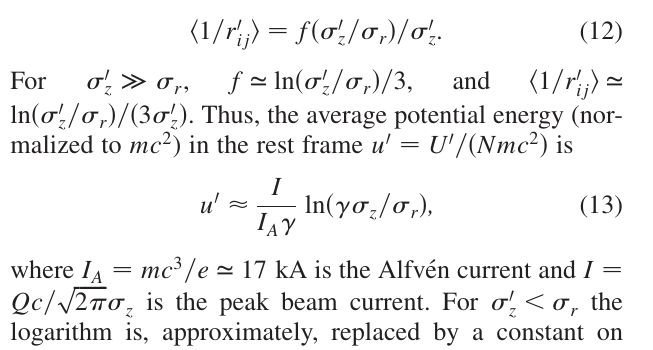
FIG. 3. The functions (cid:3) and (cid:3) 0 versus (cid:4)=(cid:5) z for b ¼ 0 : 14 .